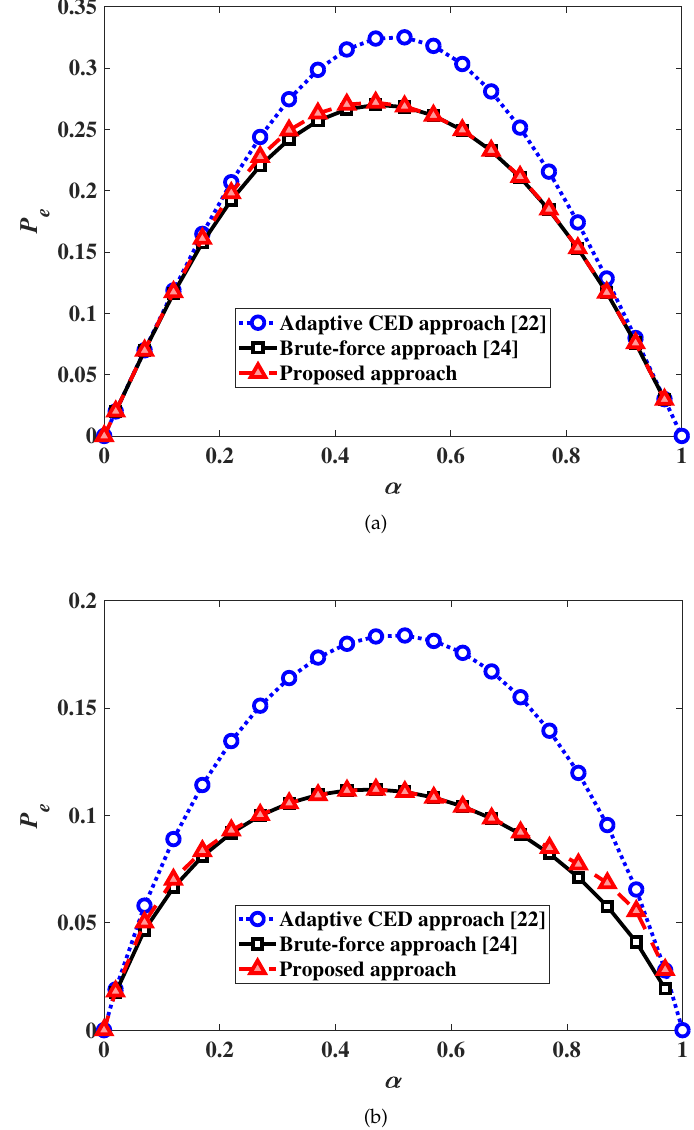
Figure 3. DEP as a function of the spectrum utilization ratio α . ( a ) SNR γ = − 23 dB; ( b ) SNR γ = − 20